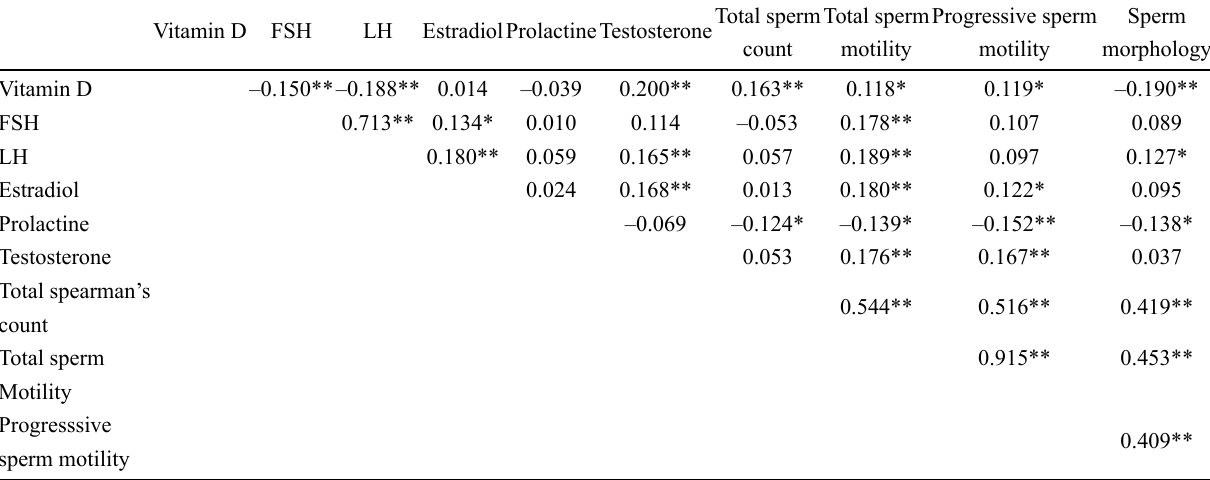
Table 3. Spearman’s Correlation Coefficient ratio of patients with idiopathic male infertility.